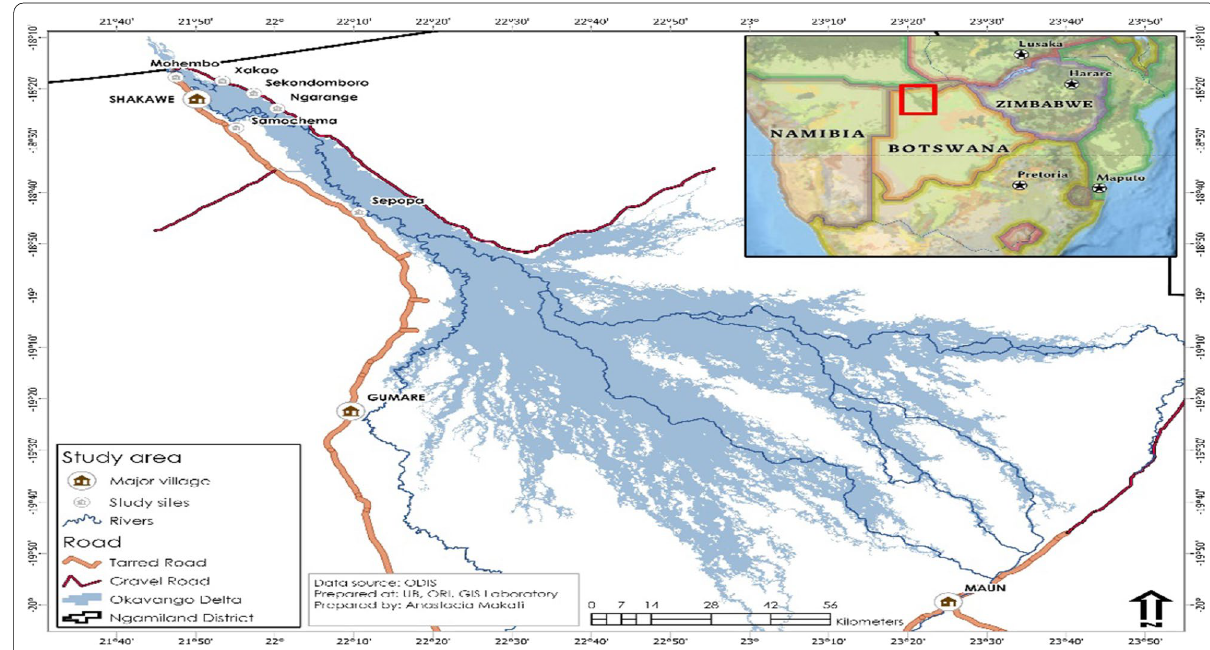
Fig. 1 Map of the Okavango delta and study sites. ODIS (2019); “okavango delta information system”, University of Botswana, Okavango Research Institute from https:// www. odis. ub. bw/ portal/